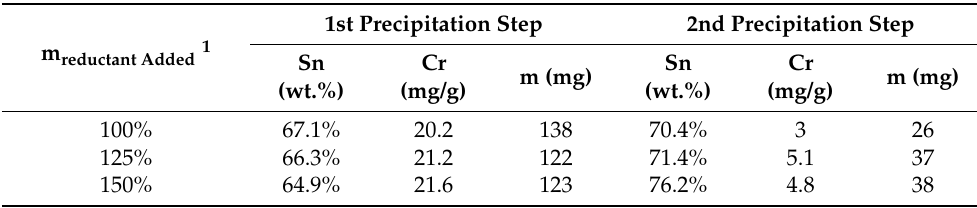
Table 8. Sn and Cr concentration in solids produced at reconstruction process in relation to